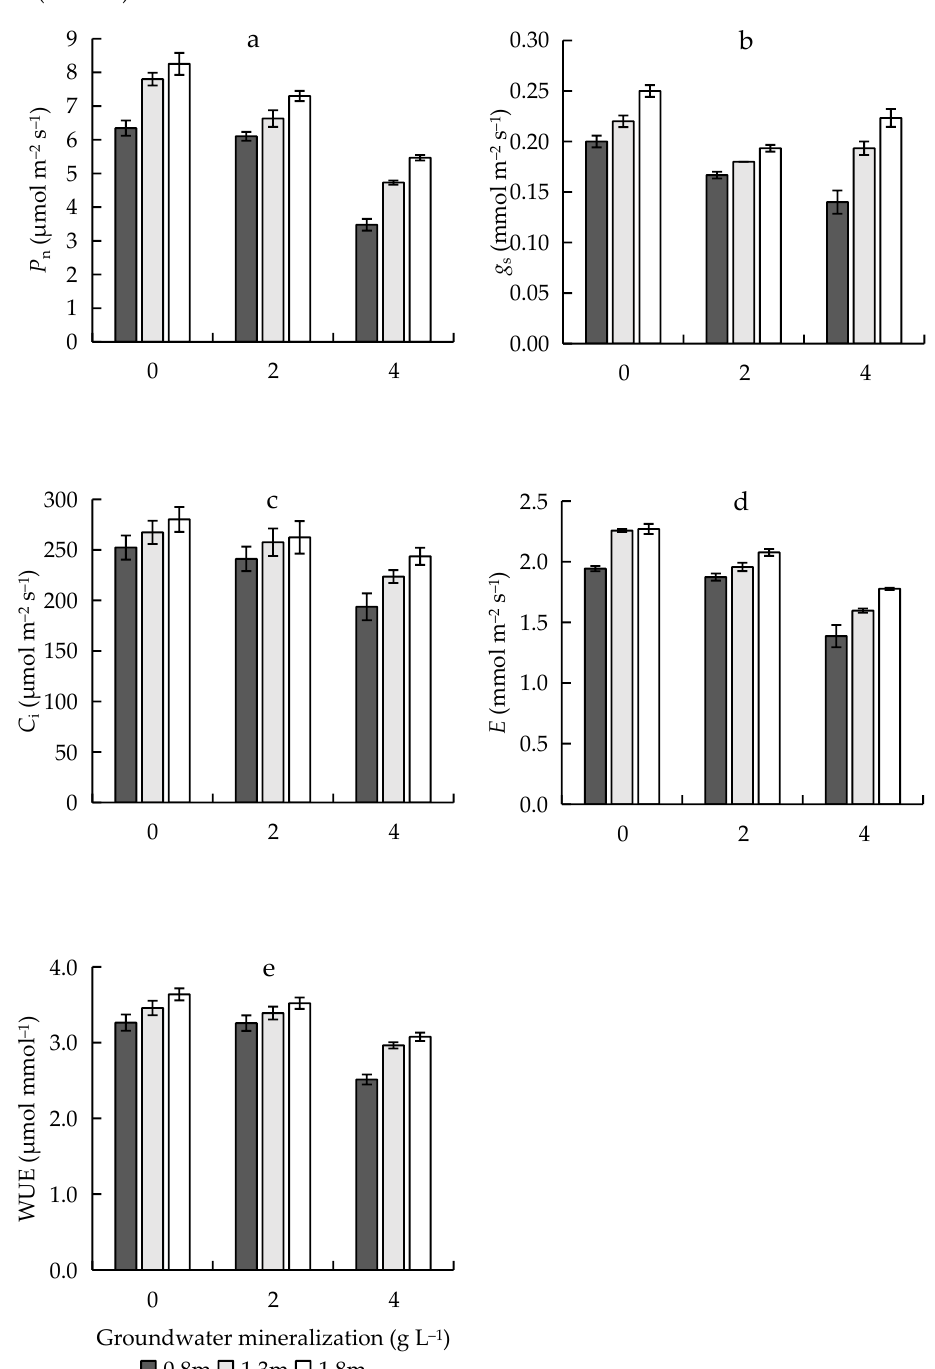
Figure 6. Effects of groundwater mineralization and groundwater depth on the photosynthetic characteristics of R. pseudoacacia . ( a ) Maximum net photosynthetic rate; ( b ) stomatal conductance; ( c ) intercellular CO 2 concentration; ( d ) transpiration rate; ( e ) water use efficiency. Error bars indicate standard errors (SEs) of the mean.